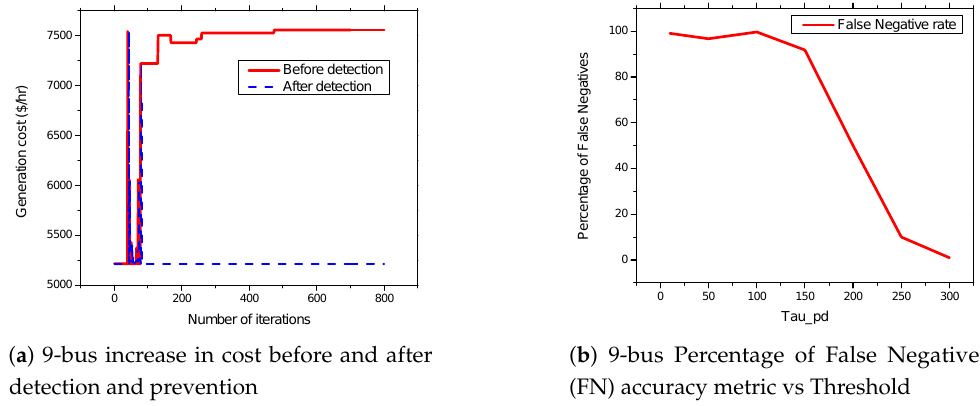
Figure 10. 9-bus systems increase in cost before and after detection and prevention and percentage of False Negatives (FN) accuracy metric vs. Threshold.